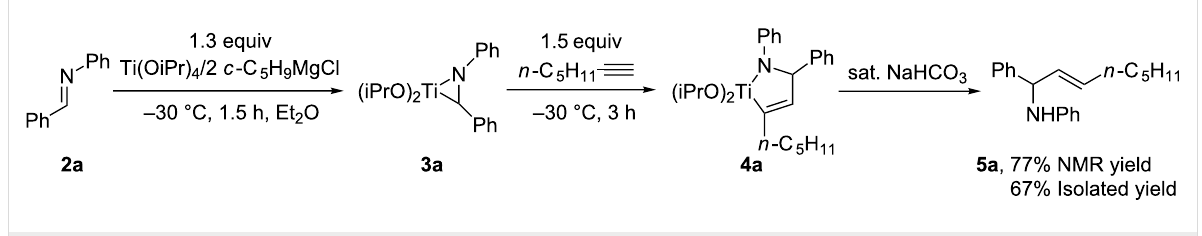
Scheme 2: Synthesis of allylic amine 5a by titanium-mediated coupling reaction of imine 2a with 1-heptyne.